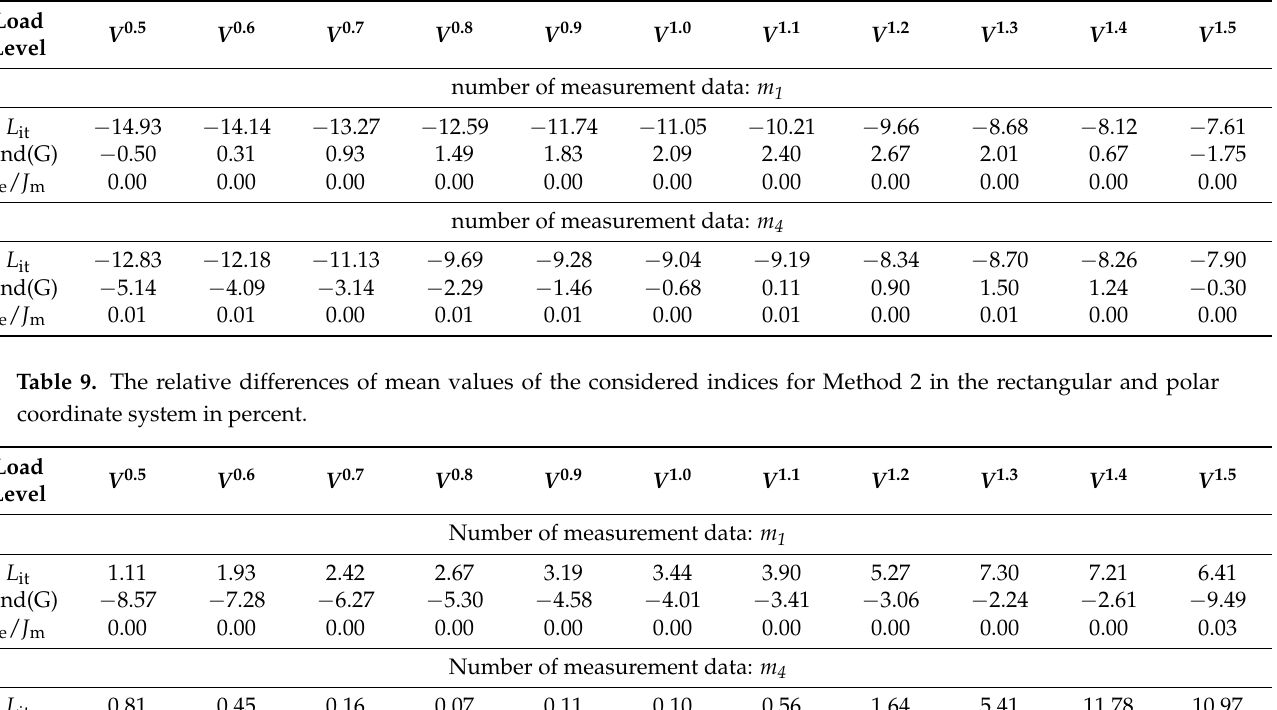
Table 8. The relative differences of mean values of the considered indices for Method 1 in the rectangular and polar coordinate system in percent.